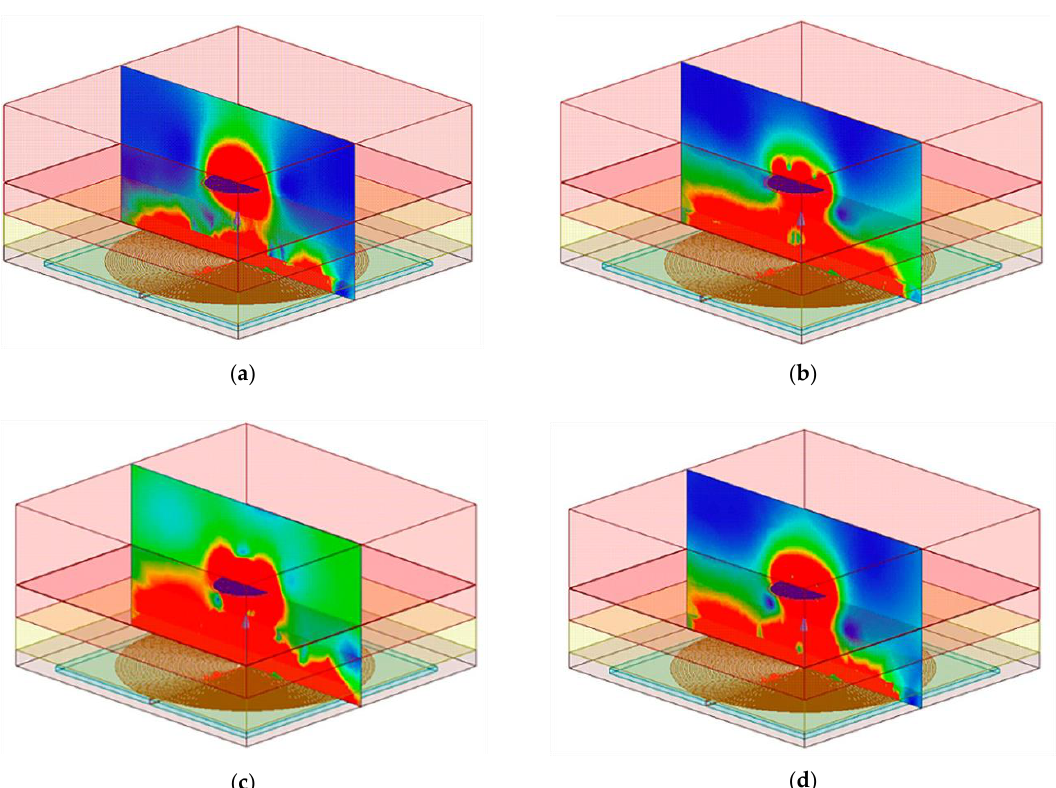
Figure 10. Variation of the magnetic flux density at ( a ) 4.5 MHz, ( b ) 7 MHz, ( c ) 9.5 MHz, and ( d ) 12 MHz.